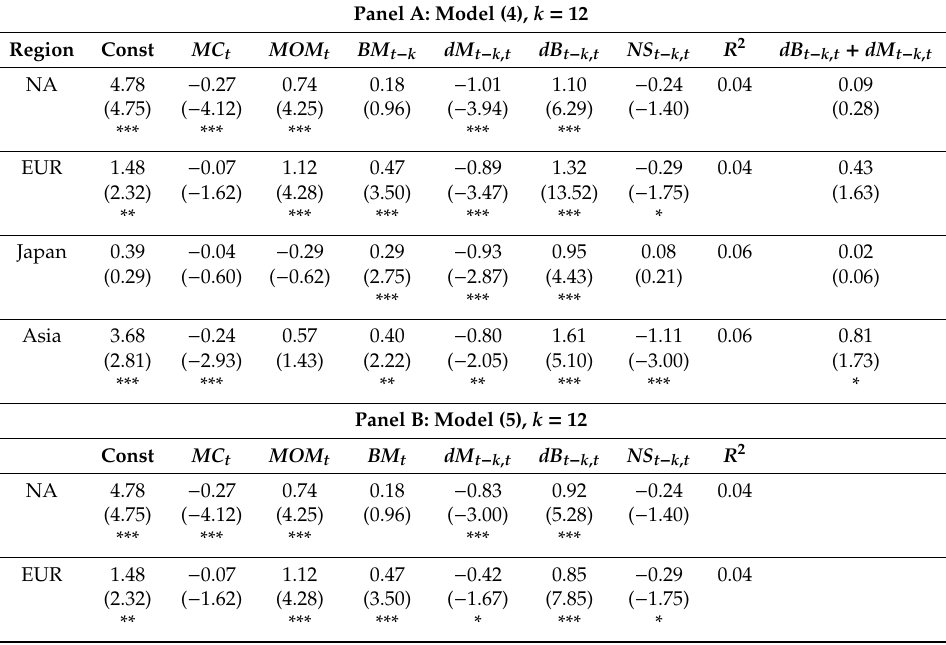
Table 6. Models (4) and (5) Regression Estimates—Subperiod 1991–2003. Results presented in Panel A are based on the same analysis of Model (4) as described in Table 2, and results presented in Panel B are based on the same analysis of Model (5) as described in Table 3. Regressions here use the set of all stocks over the subperiod 1991 to 2003. *** / ** / * indicates significance at the 1, 5, and 10% level,